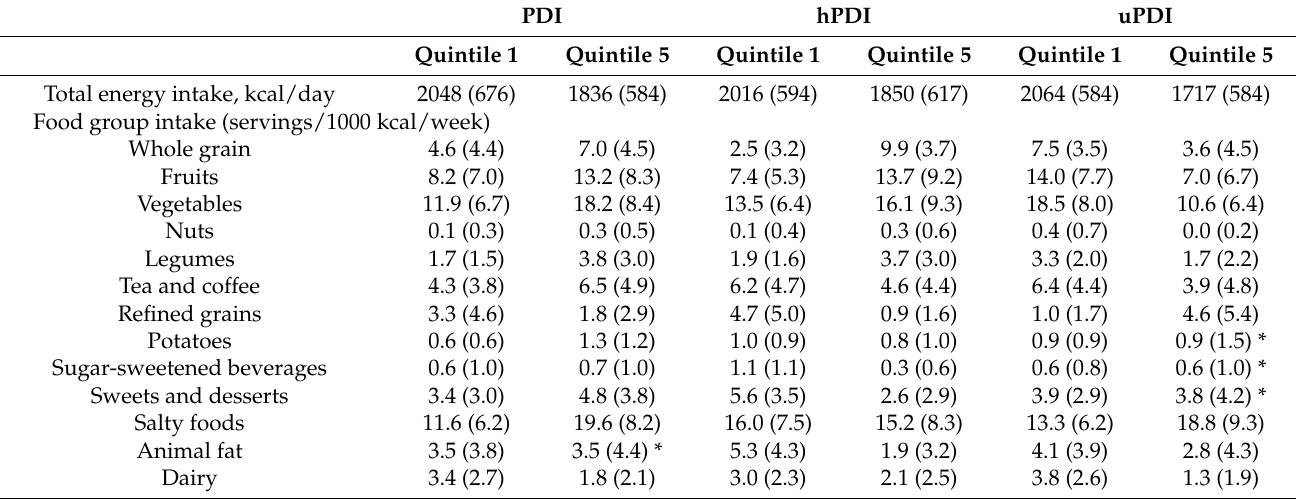
Table 2. Dietary consumption of participants in the lowest versus highest quintile of plant-based diet indices. PDI